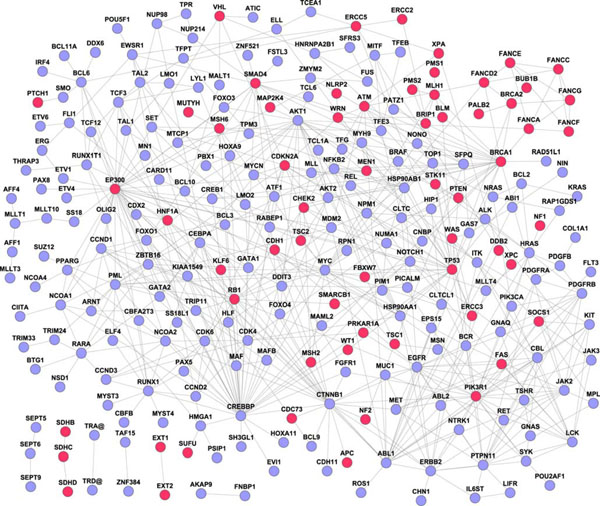
Cancer-specific subnetworks extracted from the human interactome based on their direct interactions. Recessive cancer proteins are labelled in red and dominant cancer proteins in blue. Two hundreds and forty cancer proteins could form a large network while the remaining 14 cancer proteins formed six small networks.